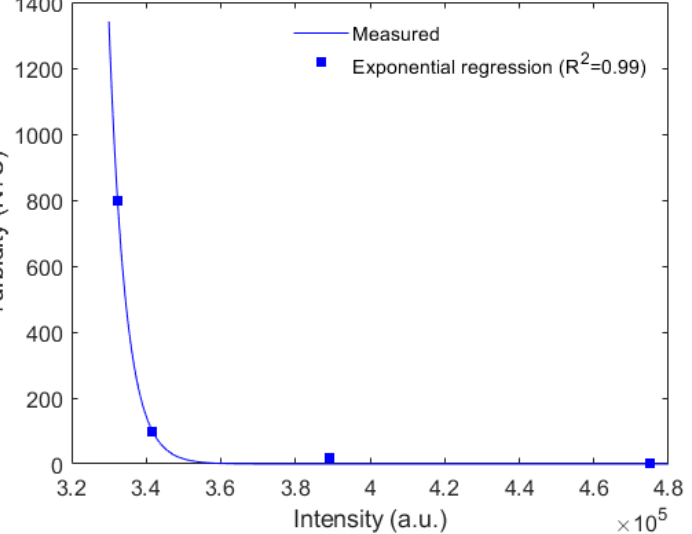
Figure 3. Turbidity as a function of optical power variation for the intensity variation-based sensor.